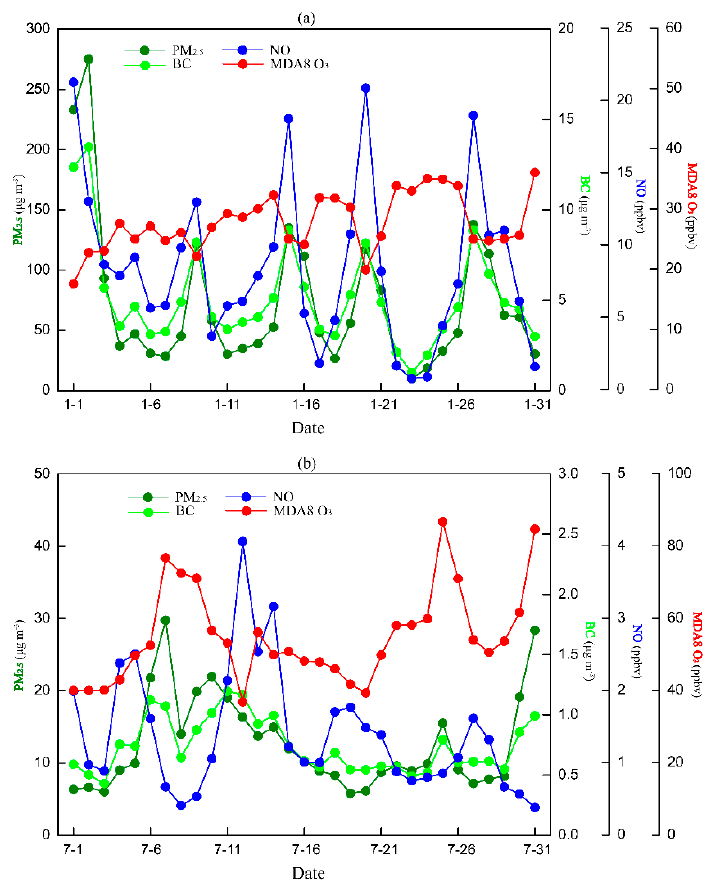
Figure 6. Time-series of simulated daily concentrations for PM 2.5 , black carbon (BC), NO, and MDA8 O 3 for ( a ) BTH in January and ( b ) PRD in July.